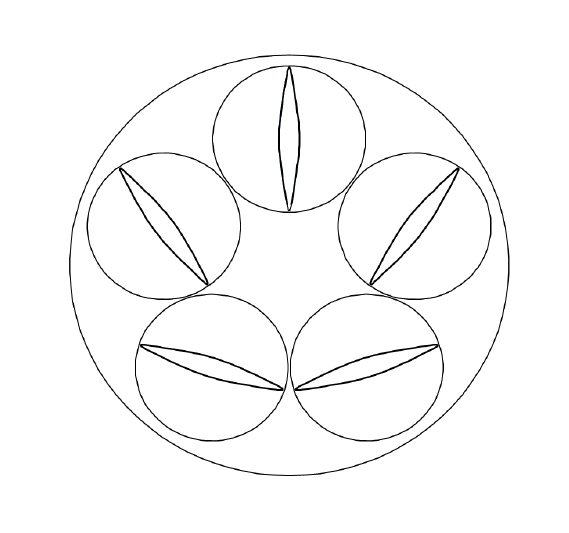
Figure 11. MS Excel geometry representation with interface